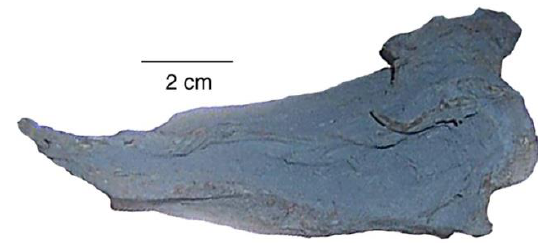
· 8H 3 (PO 4 ) 2 2 O, locality